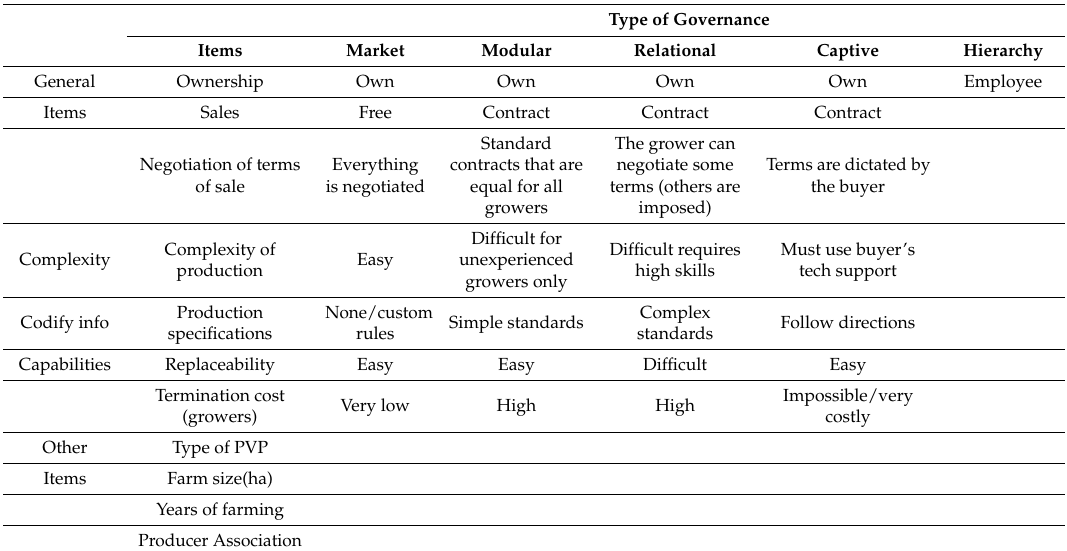
Table 1. Detecting the governance